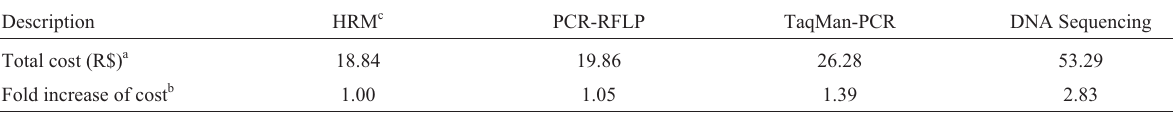
Table 2 - Costs of the TP53 -p.R337H analysis for one patient.